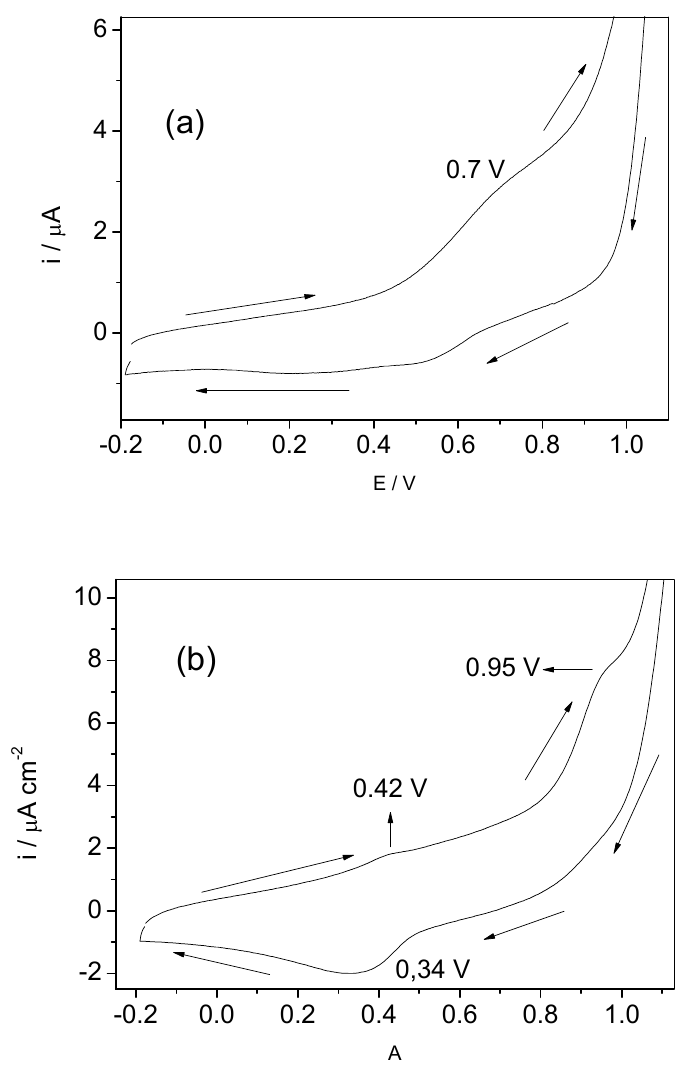
Figure 3. Cyclic voltammograms obtained for chalcone 1 ( a ) and 2 ( b ) in dichloromethane at 50 mV s − 1 and at room temperature ( 25 °C).